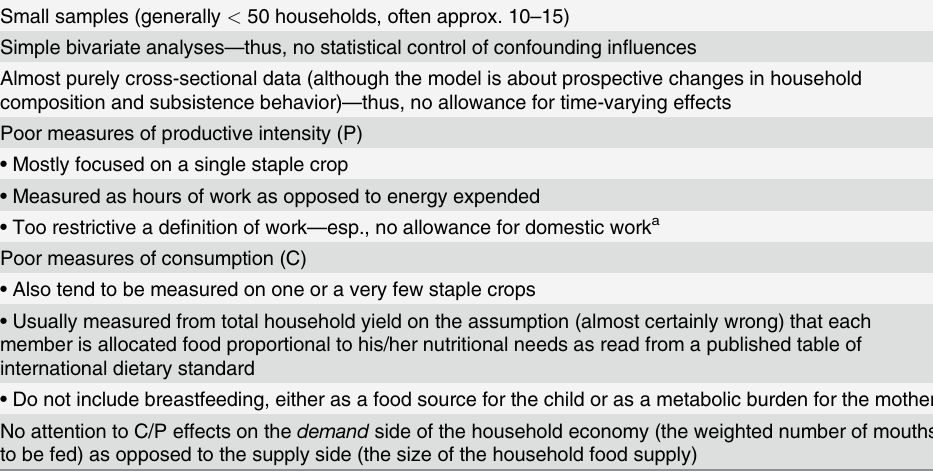
Table 1. Conceptual and statistical problems affecting most earlier tests of Chayanov ’ s model of C/ P ratios, including Chayanov ’ s own. Small samples (generally < 50 households, often approx. 10 – 15) Simple bivariate analyses — thus, no statistical control of confounding in fl uences Almost purely cross-sectional data (although the model is about prospective changes in household composition and subsistence behavior) — thus, no allowance for time-varying effects Poor measures of productive intensity